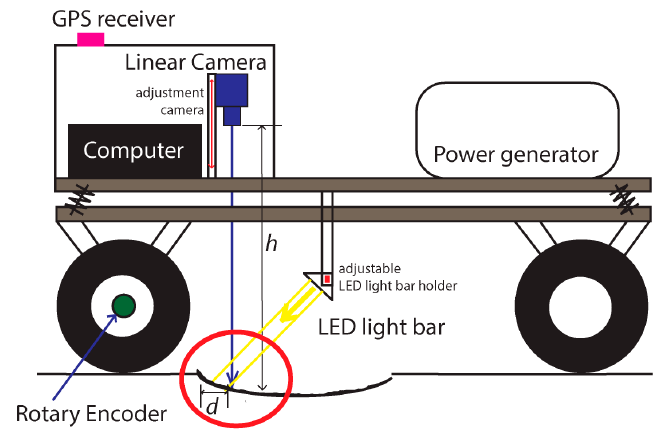
Figure 11. Road irregularities producing misalignments between the light line and the camera scanned line.